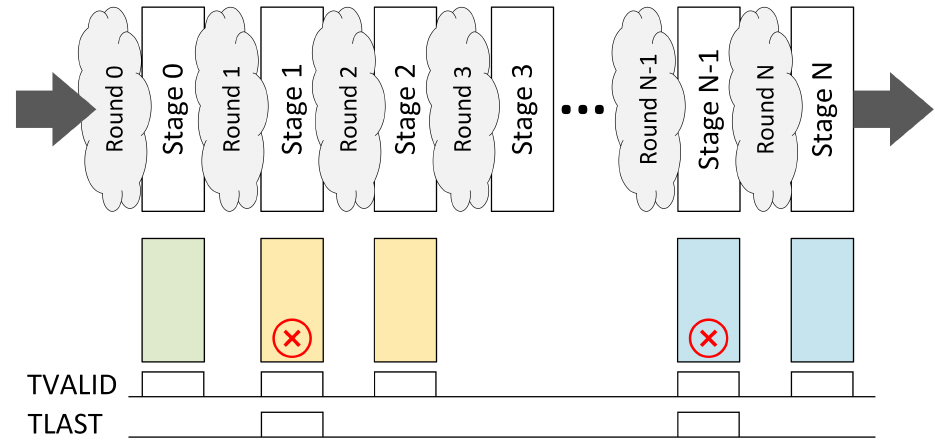
Figure 9. Pipelined hash algorithm implementation in the network probe hardware accelerator.